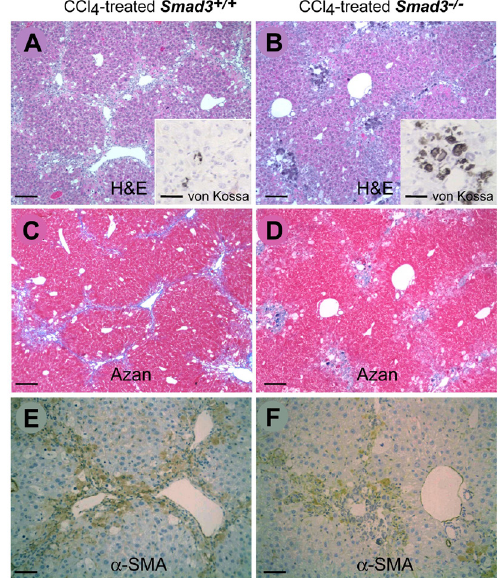
Figure 2. Hepatic fibrotic changes of Smad3 mutant mice after CCl Liver tissues of CCl -treated Smad3 +/+ ( A , C and E ) and Smad3 −/− ( B , D and F ) mice. 4 H & E stain ( A and B ); azan stain ( C and D ); and immunostain for α -SMA ( E and F ). Scale bars represent 25 µm. Inserts ( A and B ) are von Kossa-stained samples of each figure. Scale bars represent 100